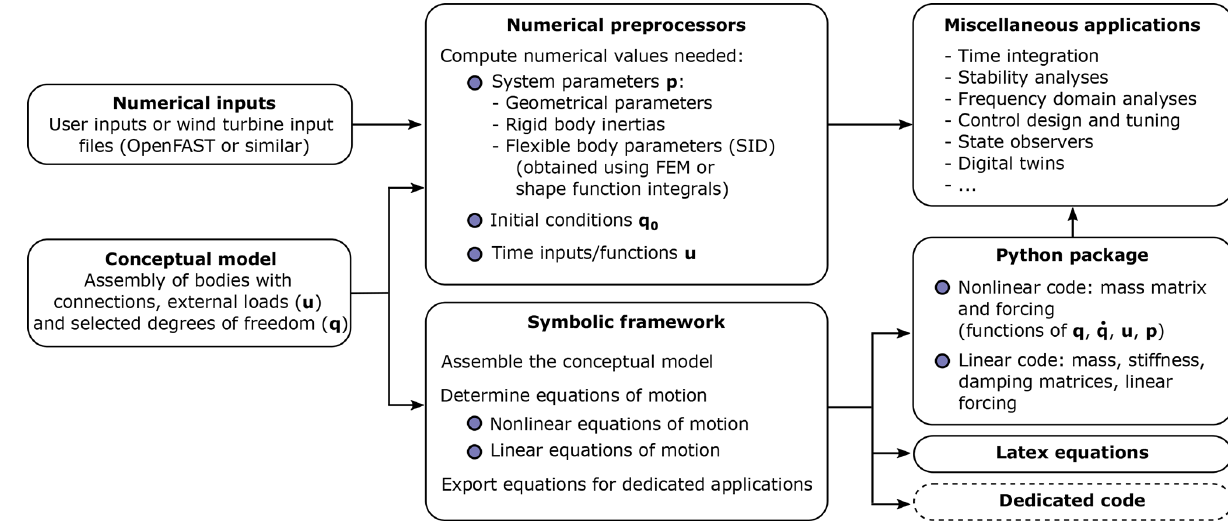
Figure 1. Typical workflow for the usage of the symbolic framework, going from numerical inputs and a conceptual model to numerical packages that can be used for various applications.